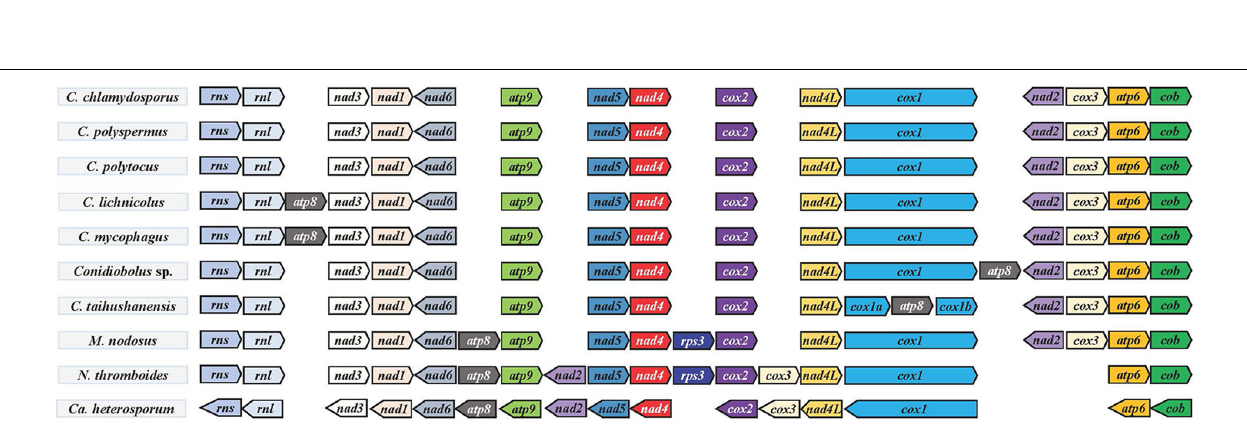
Frontiers in Microbiology |